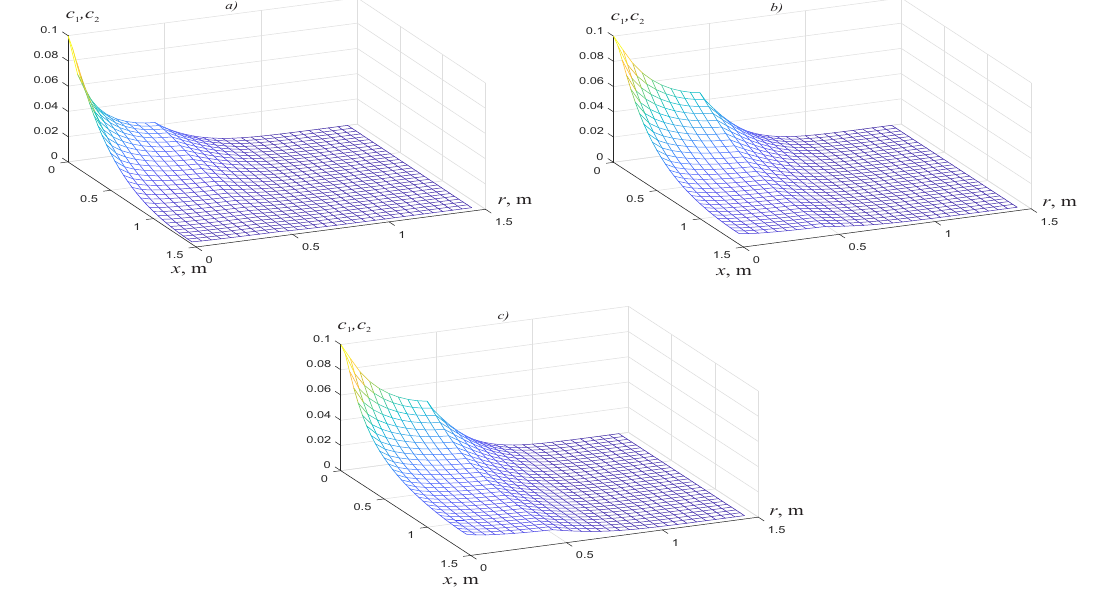
= 2, γ = 1, D = 5 · 10 − 5 m γ ∗ 1 /s, 2 1 x 2 = 2 ( a ), γ ∗ = 1.8 ( b ), γ ∗ = 1.6 ( c ) . 1 1 1